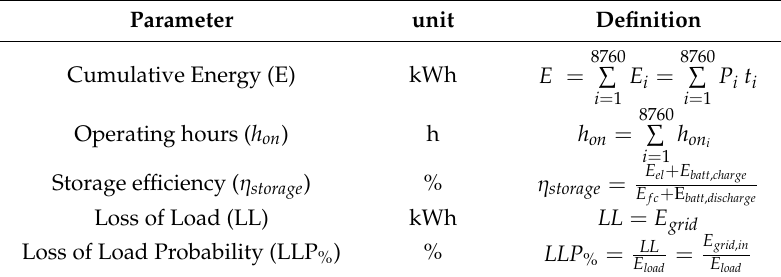
Table 3. Global evaluation